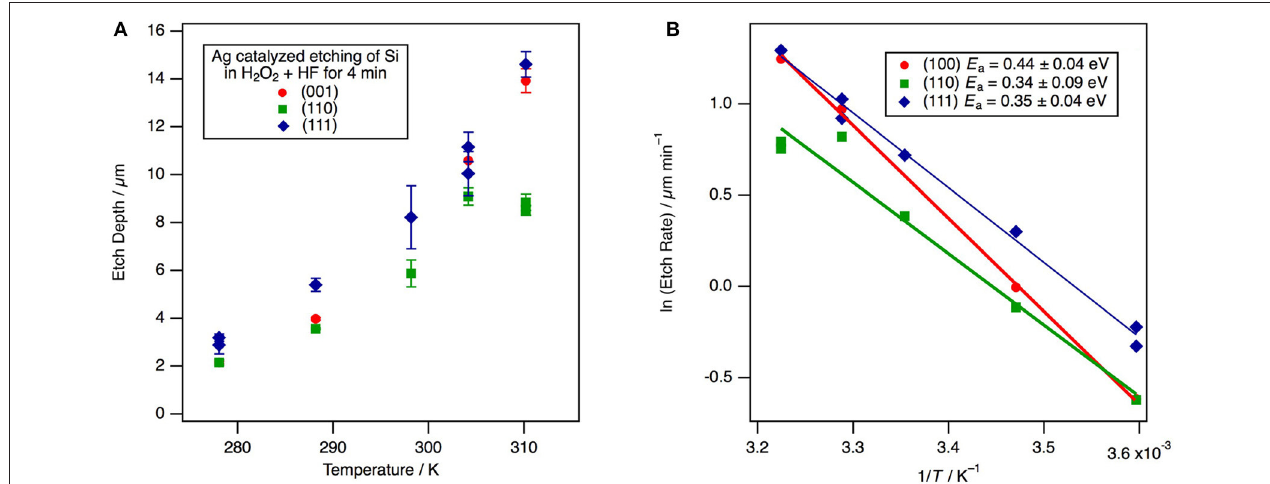
FIGURE 4 | The temperature dependence for etching along the h 001 i direction of Ag-catalyzed etch rate for (001)-, (110)-, and (111)-oriented Si substrates in H 2 O 2 + HF solutions. For all three substrate orientations the primary direction of etching is along the h 001 i directions. (A) A plot of the etch depth vs. temperature at a constant etch duration of 4min. Each point represents the mean of multiple depth measurements from an individual experiment with error bars defined by one standard deviation. (B) An Arrhenius plot of the etch rate vs. inverse